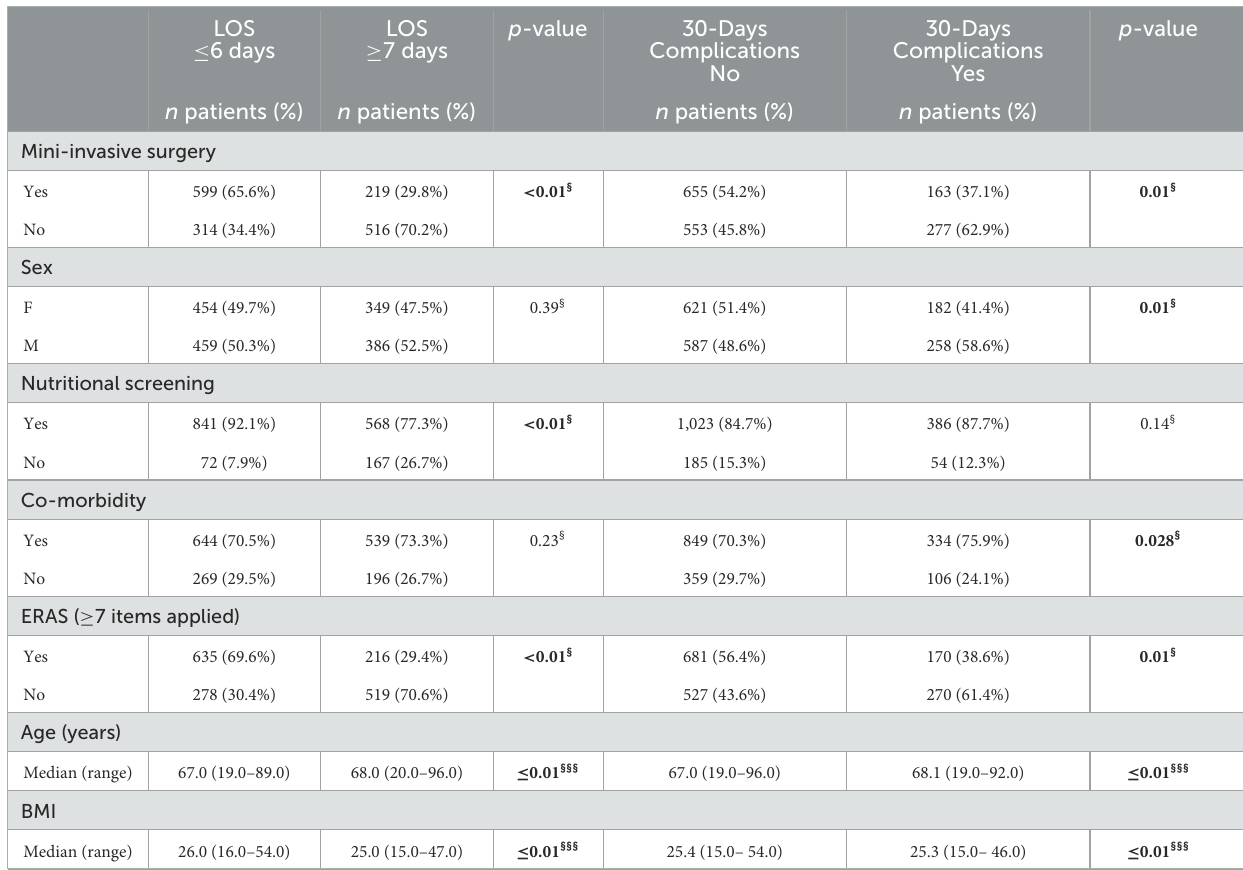
TABLE 1 Univariable analyses in the